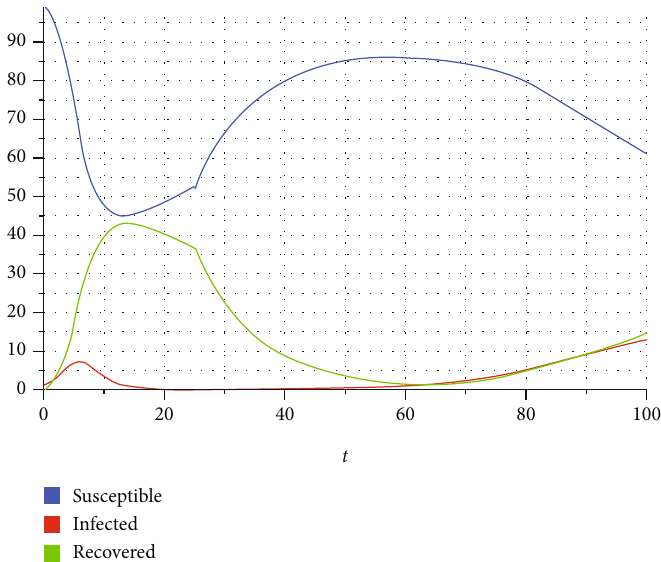
Figure 3: Evolution of functions S , I , and R in the fi rst 100